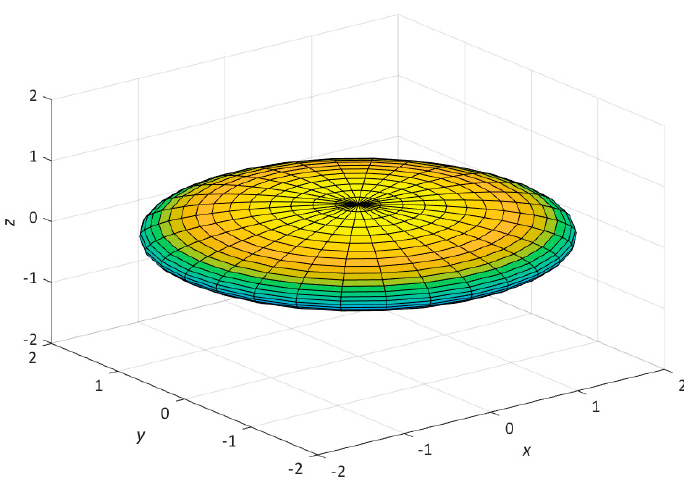
Figure 1. An oblate spheroid with centers on ( x , y , z ) = ( 0,0,0 ) and semi-major axis a = 2 and semi-minor axis b = 0.5 .